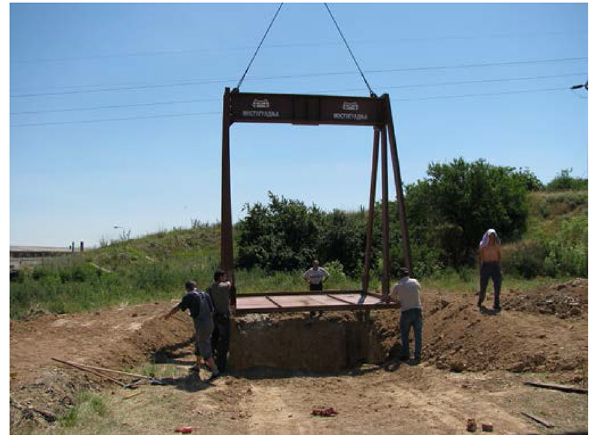
Fig. 2 Preparing of the steel test